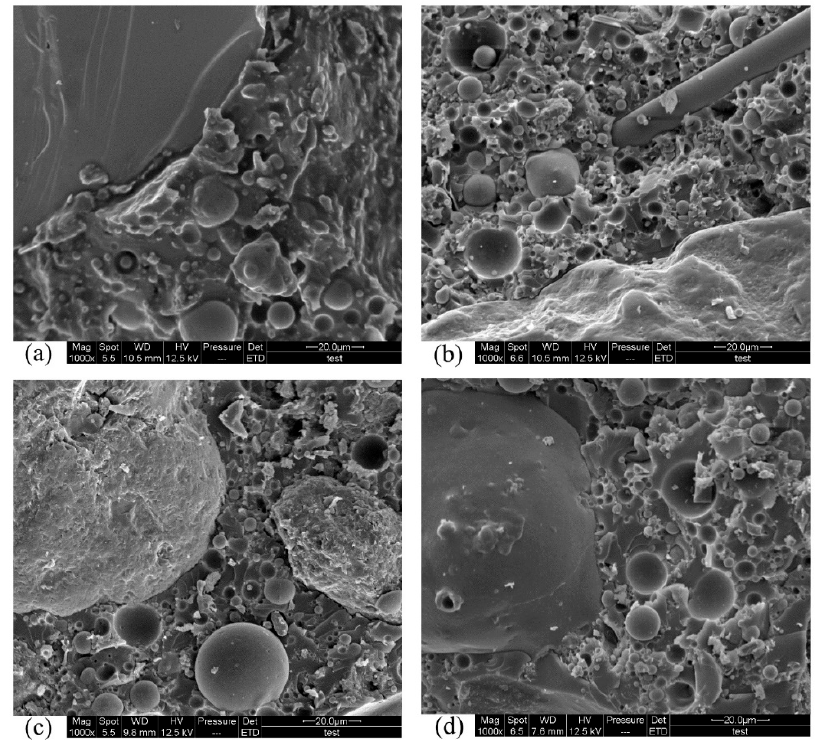
Figure 9. SEM images of the interior of specimens immersed in pH 0.5 acid solution: ( a ) uncorroded